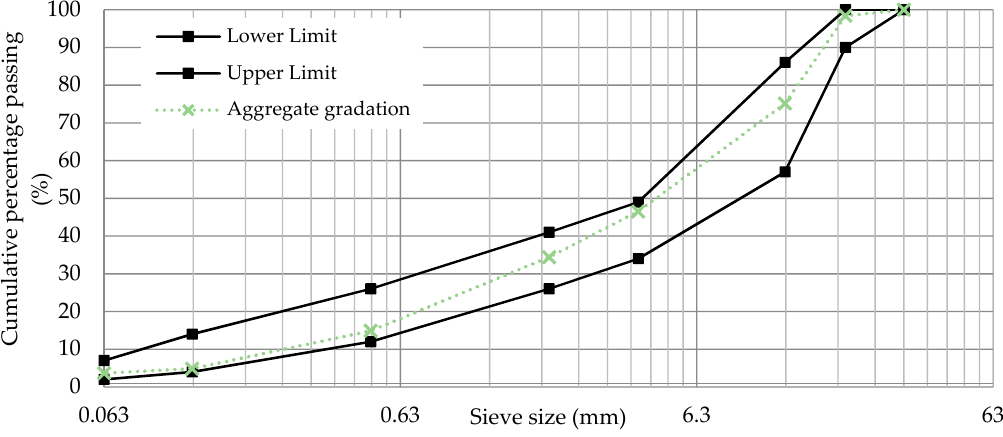
Figure 1. Grading curve of the mixture.